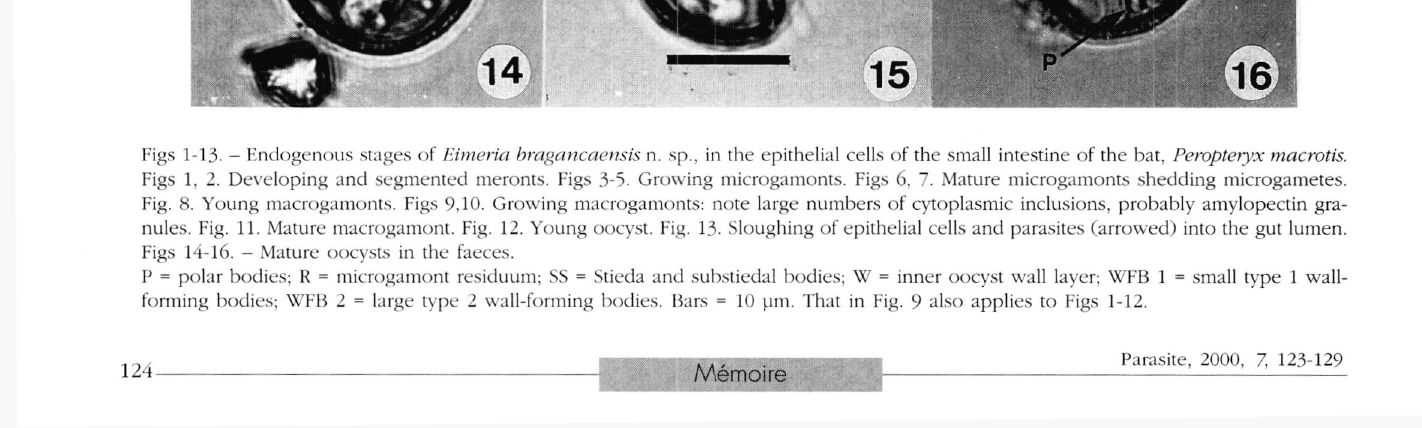
Parasite, 2000, 7,